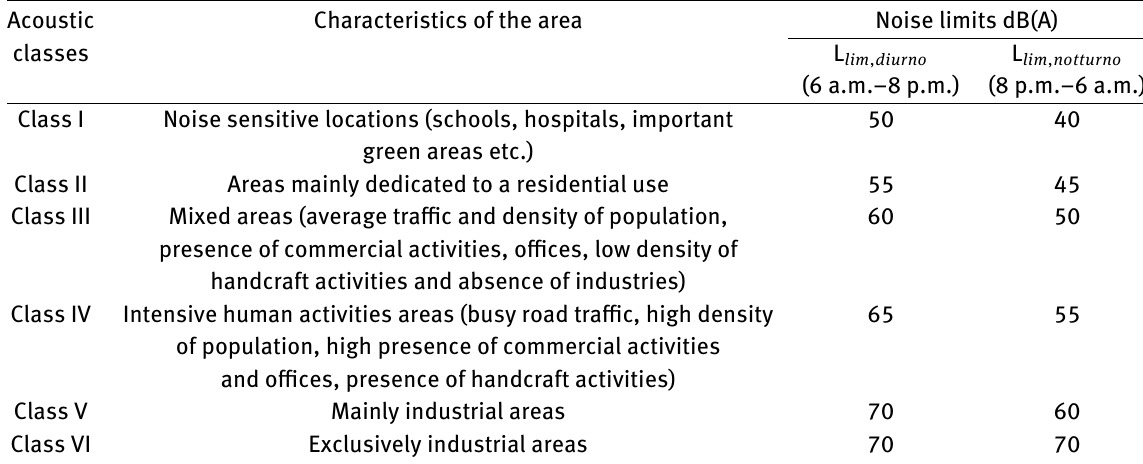
Table 6: Noise limits under the Italian